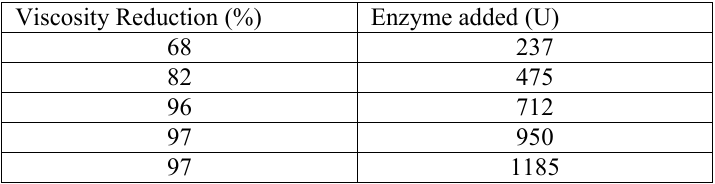
Table 5. The effect of different Bacillus subtilis NRC-B233b dextranase concentrations on sugar cane juice